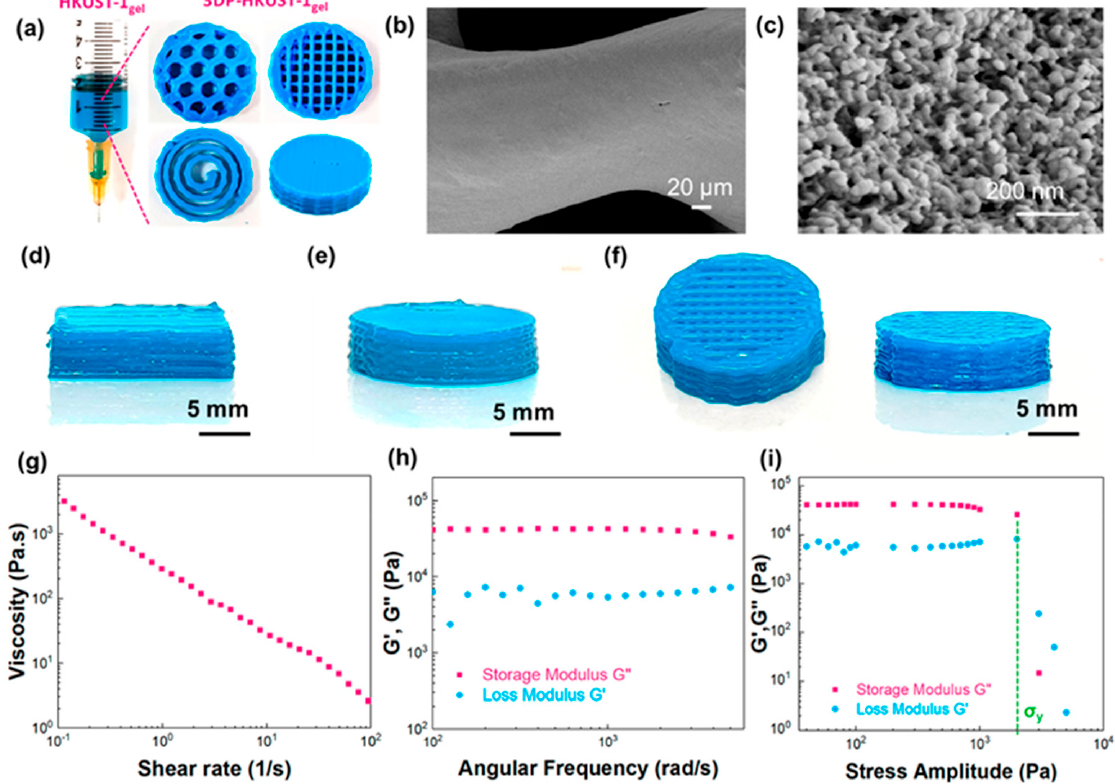
Figure 11. ( a ) Colloidal gels comprising ethanol and Cu3(BTC)2 (BTC = 1,3,5-benzenetricarboxylate) (HKUST-1) gel filled into a syringe and distinctive 3D printed assemblies. ( b ) SEM micrograph of a distinct filament from a dried 3DP-HKUST-1gel monolith. ( c ) SEM image of HKUST-1 nanoparticles within the dried 3DP-HKUST-1gel monolith. ( d , e ) Side vision of high-profile 3D-printed monoliths: ( d ) square-shaped monolith with ten number of layers and ( e ) showing a circular pellet monolith with ten layers. ( f ) Top vision and side vision of a high-profile mesh-like monolith. ( g – i ) Rheological characteristics of HKUST-1gel presentation that the gel is solid-like at rest and displays shear-thinning performance with growing shear force: ( g ) Apparent viscosity as a function of shear rate. ( h , i ) Small amplitude oscillatory shear outcomes. ( h ) The storage modulus G ′ and the loss modulus G ′′ attained against the angular frequency. ( i ) G ′ and G ′′ noted against the shear stress-amplitude at a constant frequency of 6.283 rad/s. Reprinted with permission from Ref. [99], Copyright 2020 by the American Chemical Society.